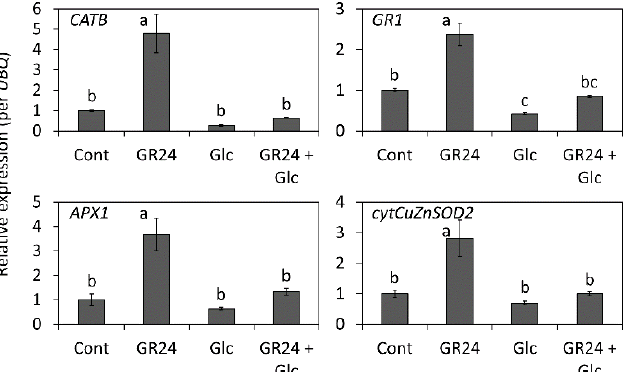
Figure 6. Effects of GR24 and glucose (Glc) on the expression of antioxidant enzyme genes in leaf segments on the third day after the treatment. Leaf segments were treated with 1 µM GR24 and 1% Glc at 25 °C in dark. The control was treated without GR24 and Glc. Transcript accumulation of each gene was measured using the qRT-PCR. The expression level of control in each gene was standardized. Values and bars represent means ± SD ( n = 3). Each biological sample has two technical replicates. Letters show a significant difference ( p < 0.05) as determined by Tukey’s HSD test.